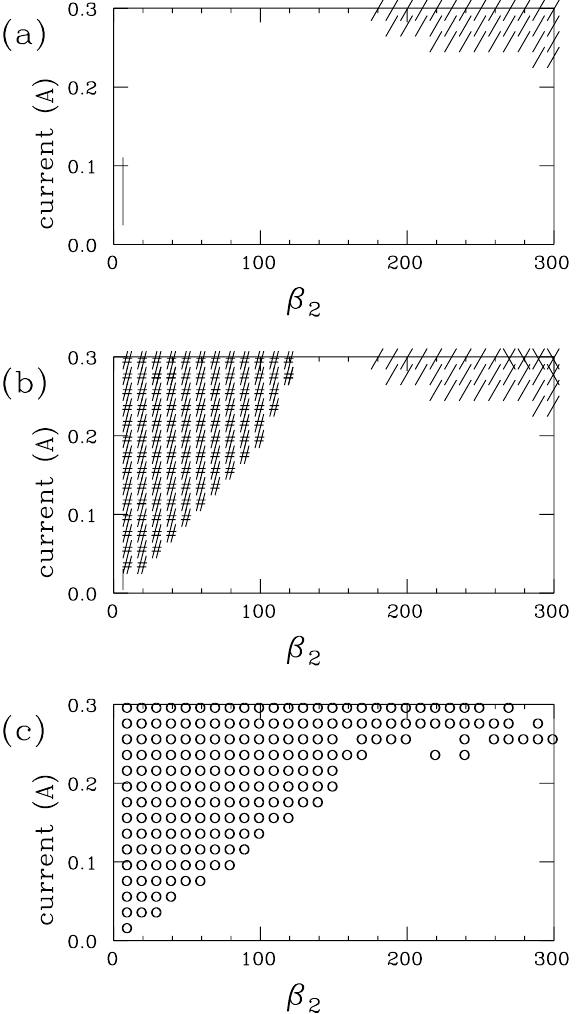
FIG. 11. (a) Robinson instabilities are predicted without con- sideration of mode coupling, for active Landau-cavity opera- tion with optimally lengthened bunches in the LF20 lattice, with a fundamental rf voltage of 50 kV. A symbol is plot- ted when Robinson instability is predicted for a given ring current and effective rf coupling of the Landau-cavity ( b 2 ). Vertical line: dipole instability; /: equilibrium phase instability. (b) Dipole-quadrupole mode coupling is included in Robinson instability predictions. Vertical line: coupled-dipole instability; #: fast mode-coupling instability; /: equilibrium phase insta- bility; \: zero-frequency coupled dipole-quadrupole instability. (c) Instabilities observed in 500 000 turn simulations.